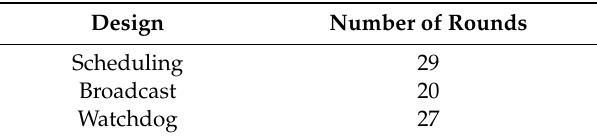
Table 8. Number of Table 8. Number of rounds.